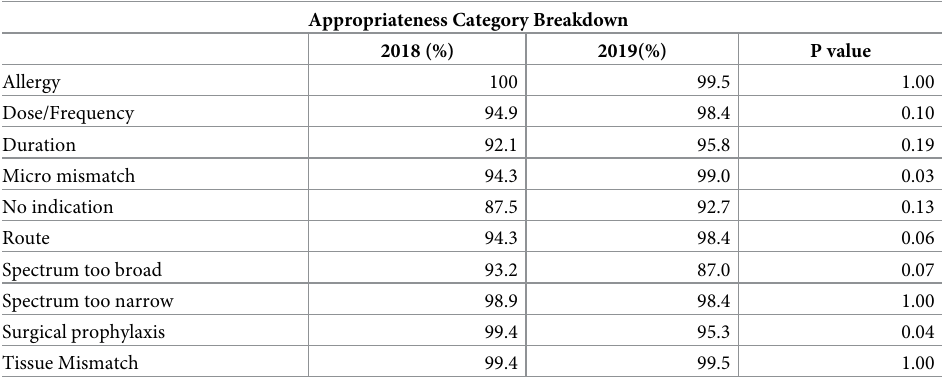
Table 1. Appropriateness by